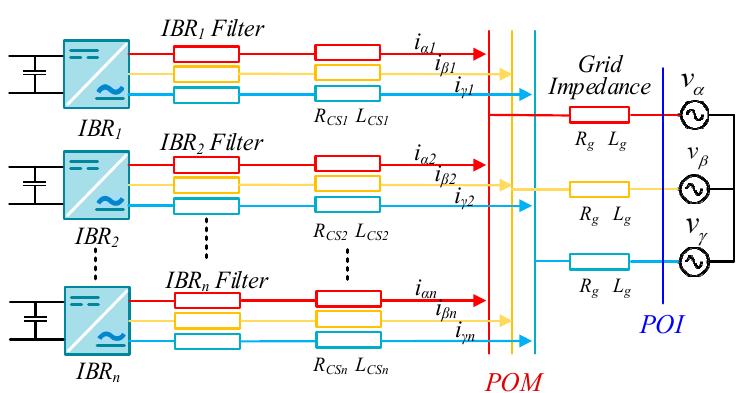
Figure 4. A grid-connected IBR plant including IBRs, IBR filters, collector impedances, and grid impedance.